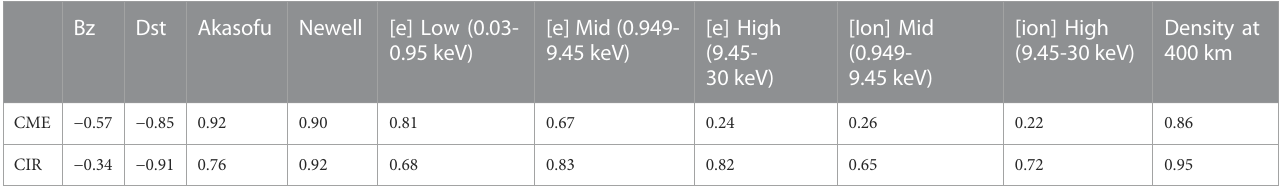
TABLE 2 Normalized correlation coef fi cient between NO cooling fl ux and other parameters during CME-and CIR-storms. Bz Dst